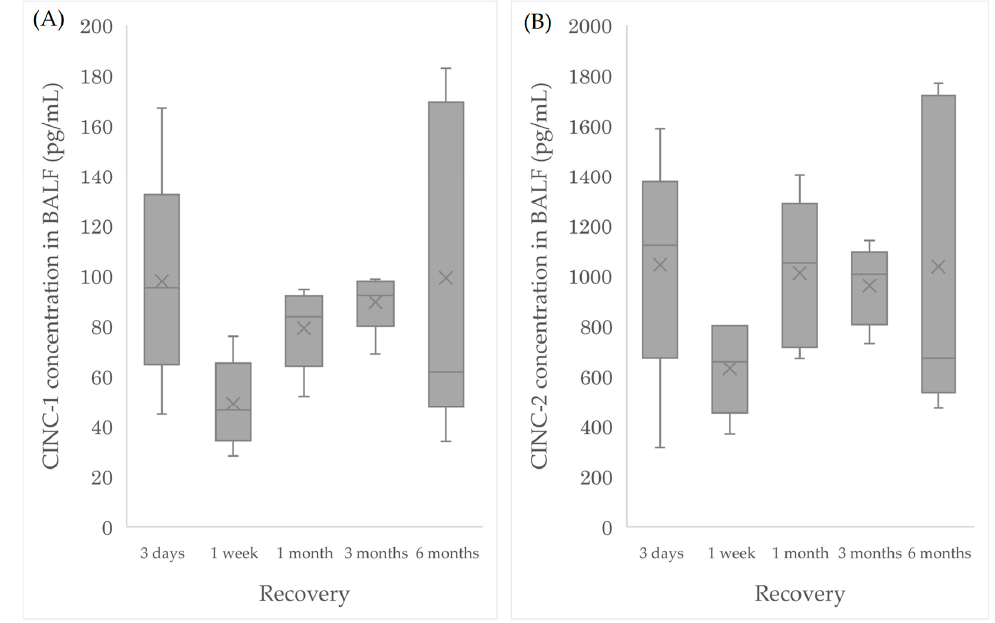
Figure 6. Concentration of CINC-1 and CINC-2 in BALF following intratracheal instillation of SiO 2 . ( A ) CINC-1 and ( B ) CINC-2 showed that the increasing tendencies were bimodal.